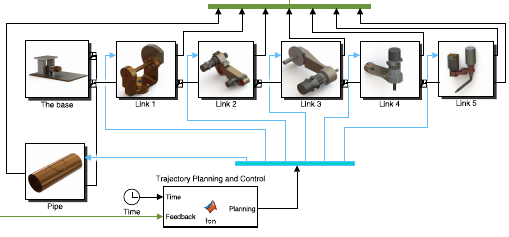
Fig. 7: The Robot system in Matlab Simulink.